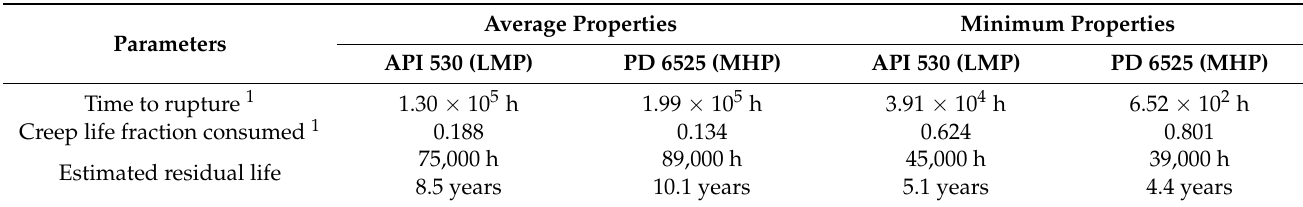
Table 5. Residual life calculation results for L2 from various empirical calculation